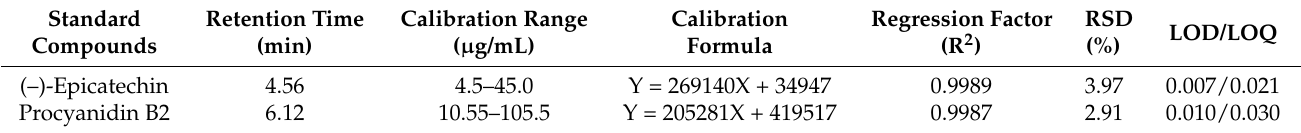
Table 1. Parameters of the analytical method of the flavan-3-ols and